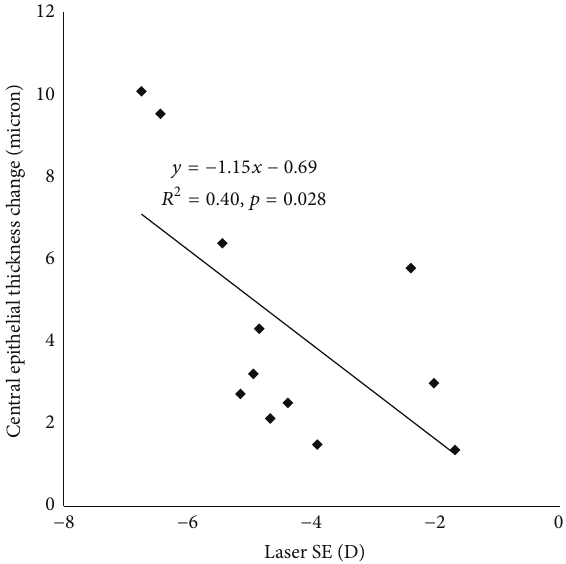
Figure 4: Correlation between central epithelial thickness changes with laser spherical equivalent (SE).